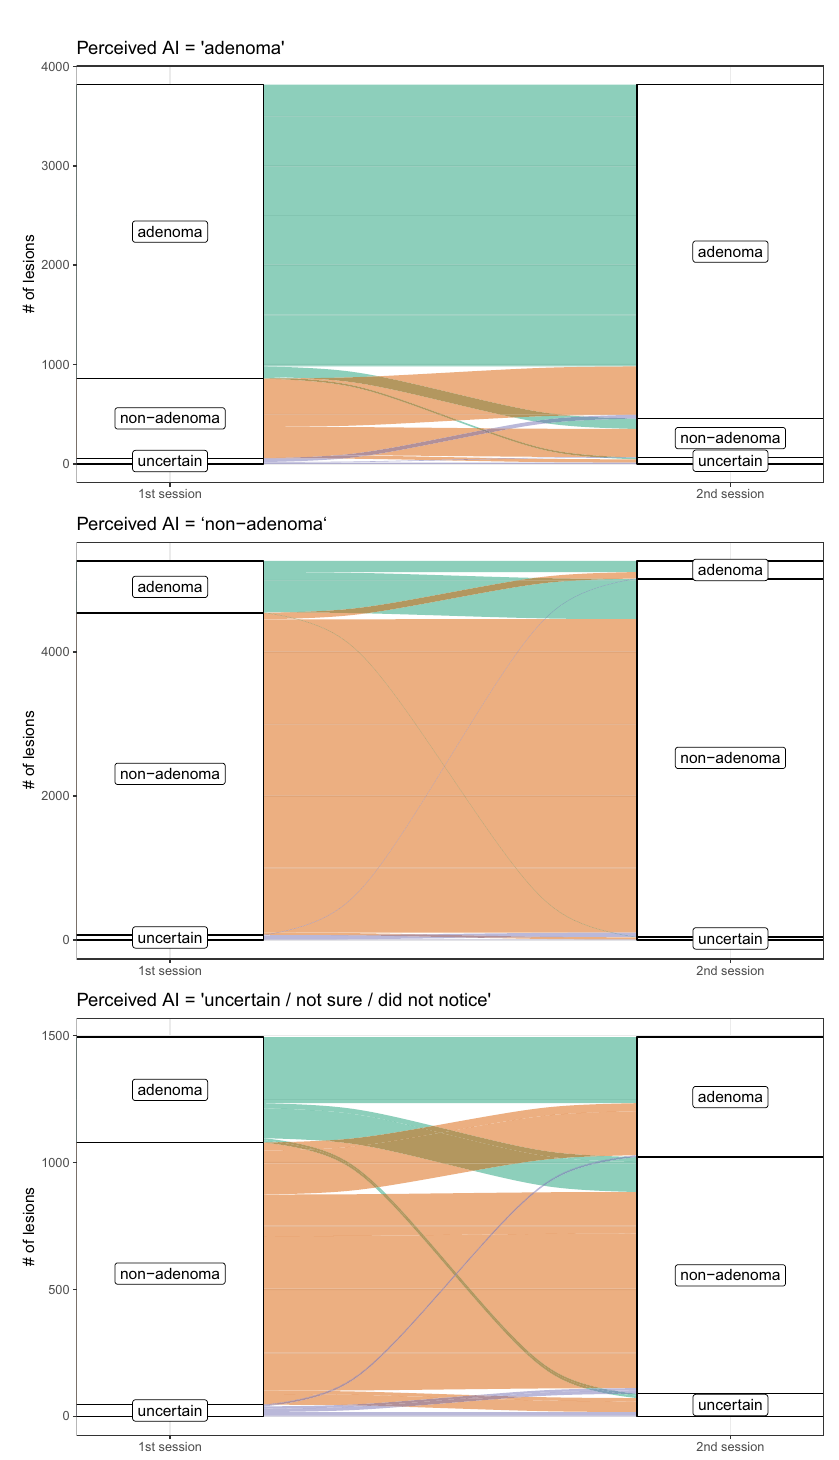
Figure 3. Influence of the ai: alluvial diagrams representing changes in endoscopist’s opinion between the two sessions as a function of perceived ai